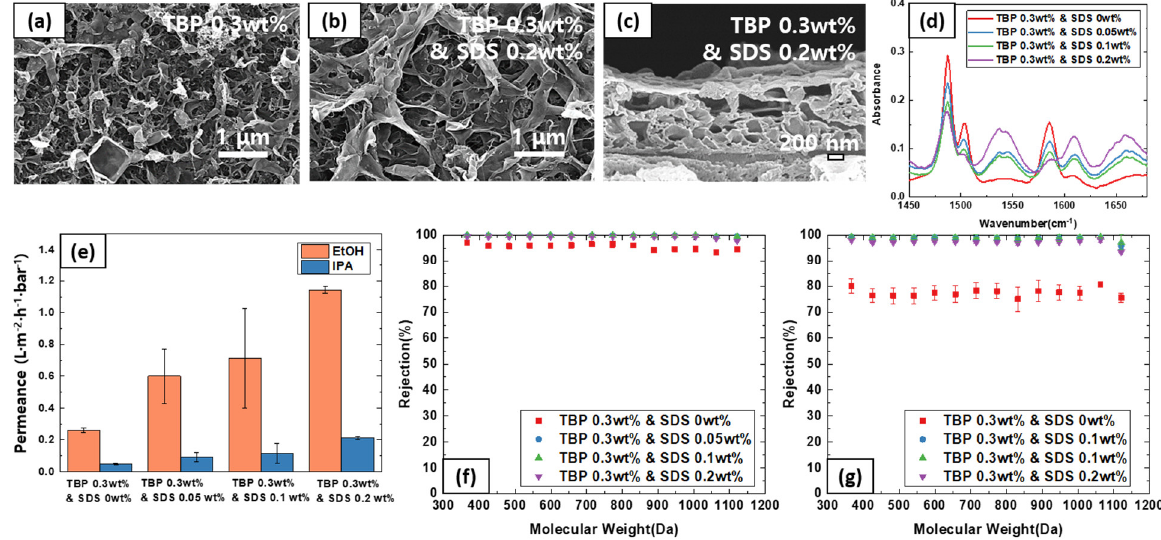
Figure 6. Effect of SDS and TBP additives on ( a , b ) surface SEM images, ( c ) cross-sectional image, ( d ) FTIR spectra, ( e ) solvent permeance, ( f ) PPG rejection profile in EtOH, and ( g ) PPG rejection profile in IPA.